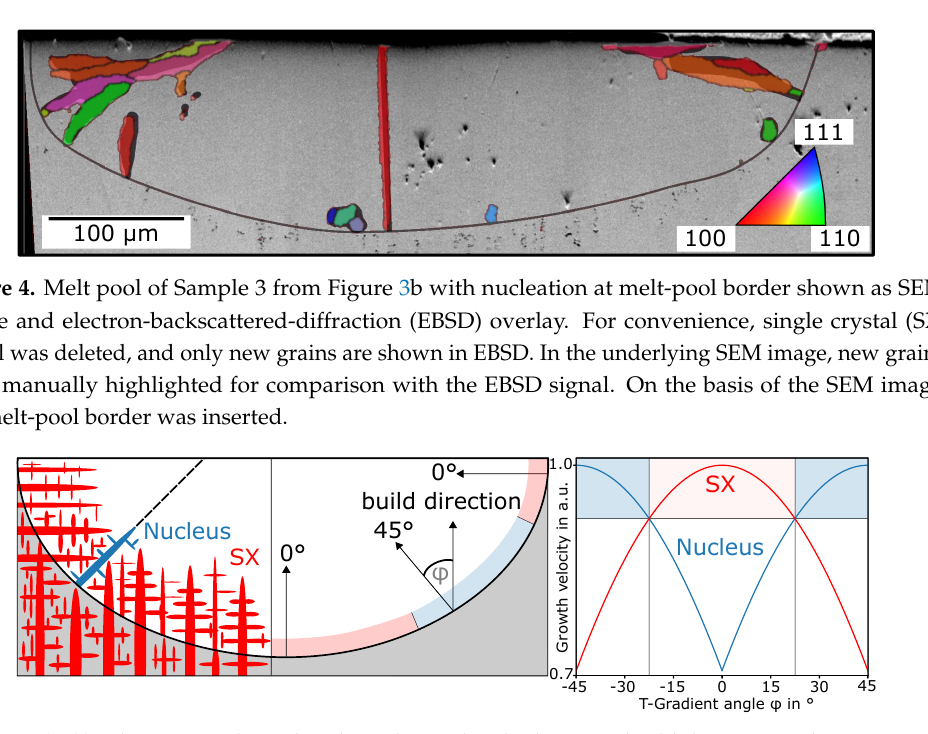
Figure 5. ( left ) Schematic melt pool with angle ϕ at border between build direction and temperature gradient. ( right ) Normalized growth velocities for same undercooling cos ( α − | ϕ | ) for different orientations α of SX base material (0 ◦ ) and nucleus (45 ◦ ) to the build direction. Areas where SX or nucleus grew faster because of better orientation marked either in red or blue in both